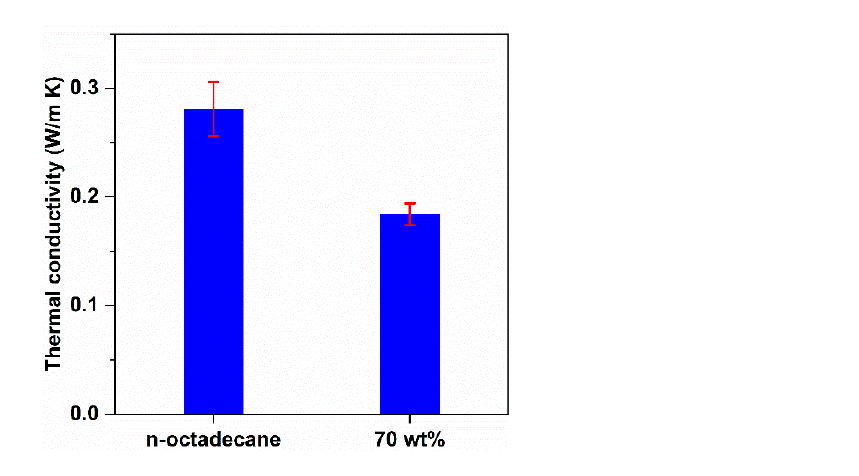
Figure 8. Thermal conductivities of pure n-octadecane and the 70 wt% n-octadecane/FS PCC.